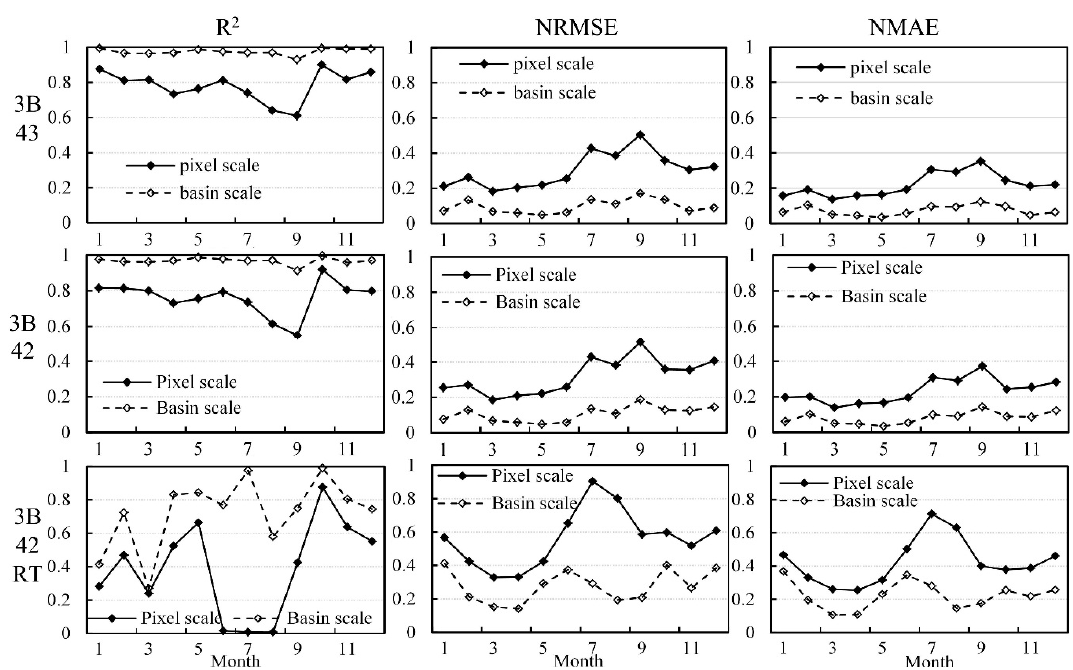
Figure 10. Monthly averaged statistical indices at pixel scale and basin scale, including R 2 , NRMSE and NMAE .